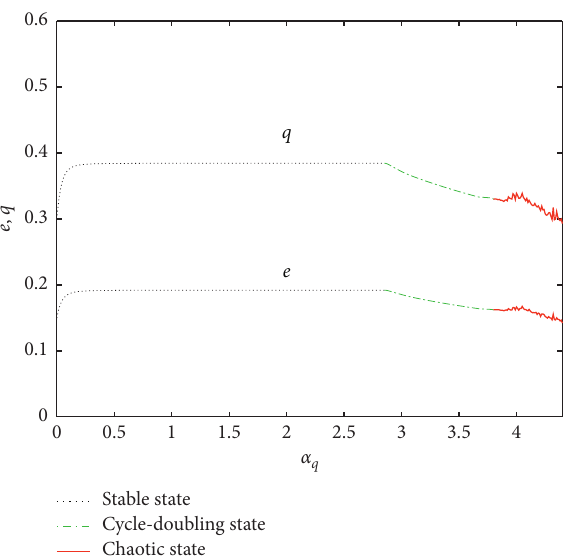
� 2 , α � 0 . 5. (b) α q e